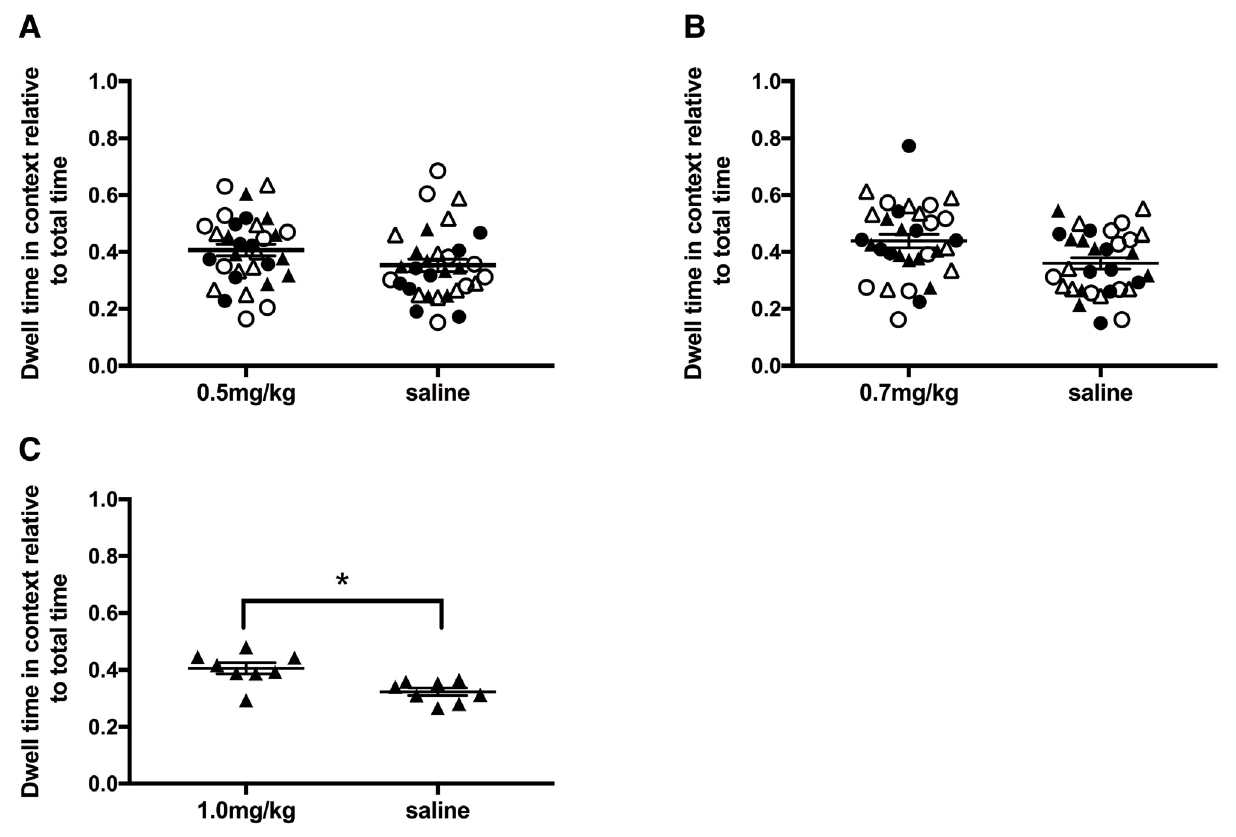
Figure 1. Dwell time in the previously paired (black) and unpaired (white) contexts during CPP. A . 0.5mg/kg d-amphetamine. B . 0.7mg/kg d-amphetamine. C . 1.0mg/kg d-amphetamine. Note 0.5 and 0.7mg/kg d-amphetamine was tested in all strain and sex groups and 1mg/kg was tested only in LER males to confirm previously published work. * p < 0.05. Individual data plus mean and SEM. LER females (closed circle), LER male (closed triangle), WR female (open circle), WR male (open triangle).